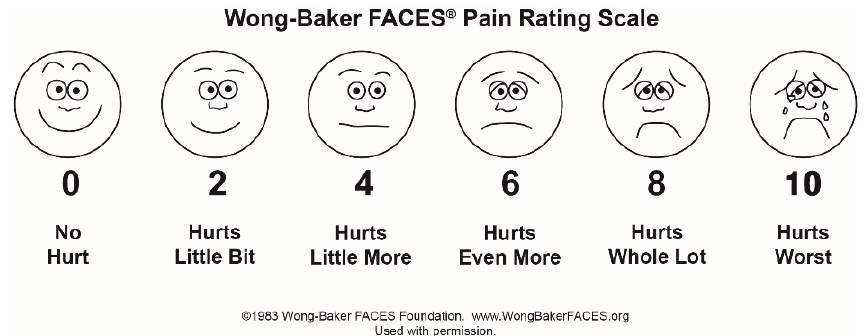
Figure 2. Wong–Baker FACES Pain Rating Scale based on facial appearance relative to pain